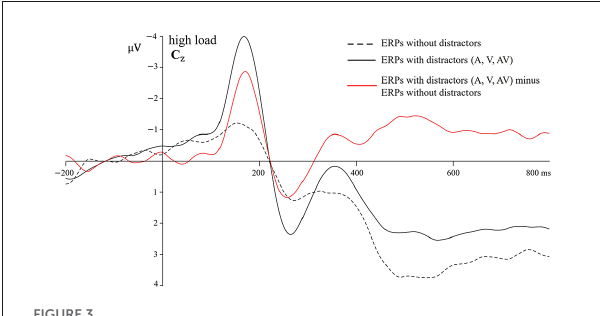
FIGURE3 Overlap correction. Averaged ERPs with distractors (averaged with overlaps), ERPs without distractors, and corrected averaged ERPs (averaged ERPs with distractors minus ERPs without distractors) under high load conditions at the C Z electrode. ERPs, event-related